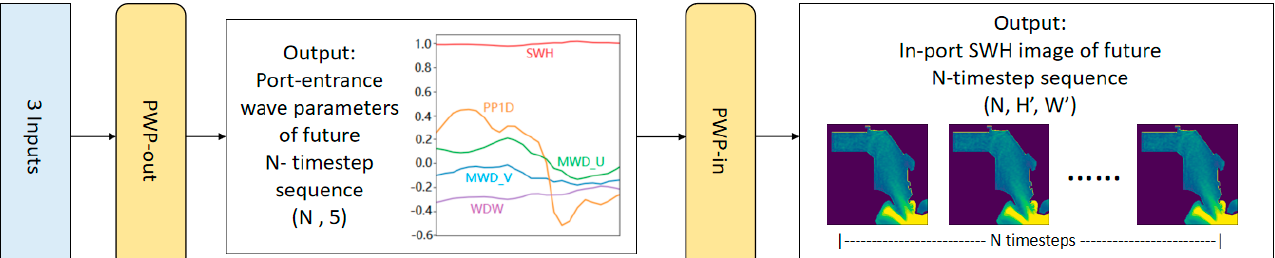
Figure 4. PWPNet structure